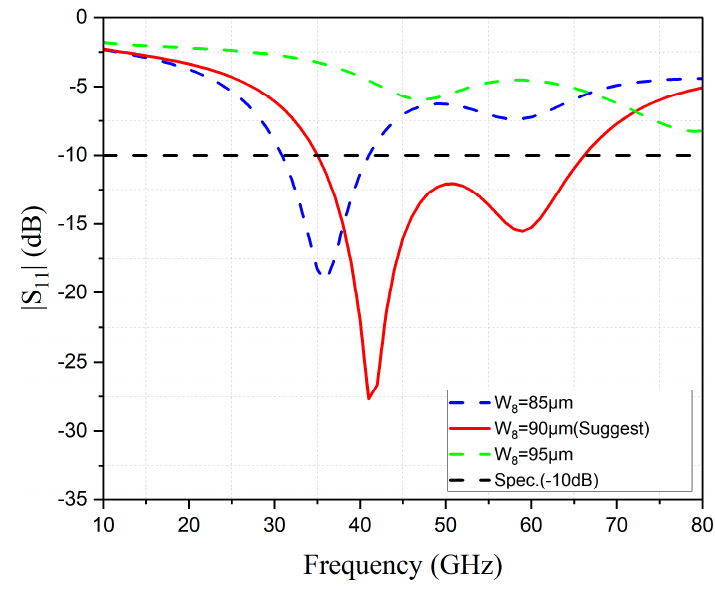
Figure 11. Reflection coefficient of W 8 variation.